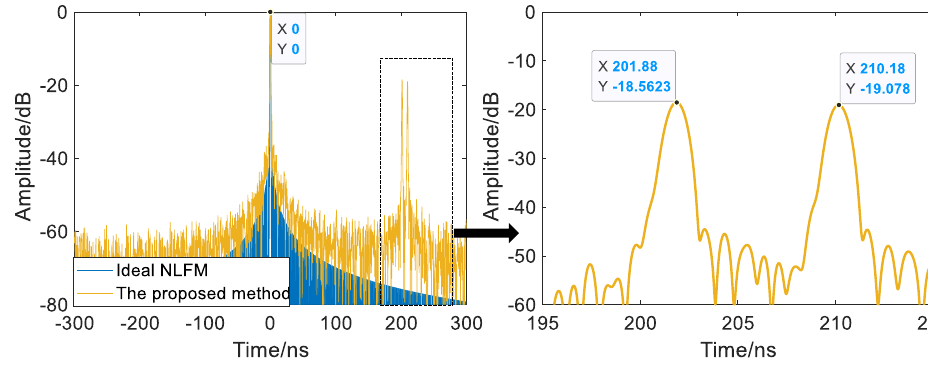
Figure 13. The results of the two-point experiment.